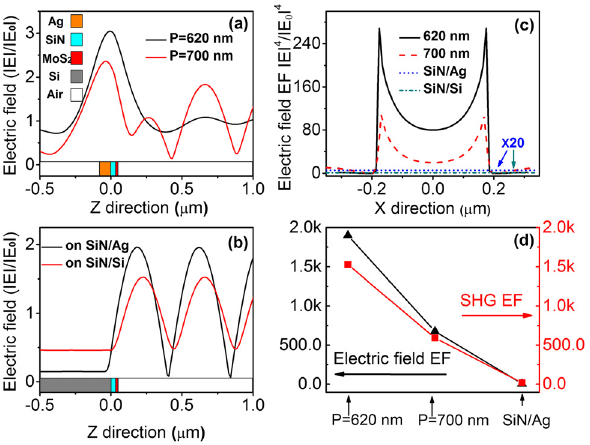
Figure 4: (a) The electric field E / E 0 distribution along z direction at the hole center of the metallic perforated structure with P = 620 (black line) and 700 nm (red line). (b) The electric fi eld E / E 0 distribution along z direction in the SiN/Ag (black line) and SiN/Ag (red line) substrate. (c) The electric fi eld E 4 / E 4 direction at monolayer MoS 2 position for the different substrate. (d) The electric fi eld enhancement factor (EF) E 4 / E 4 and second-harmonic generation (SHG) EF (black triangle) of monolayer MoS 2 on different substrates, respectively.